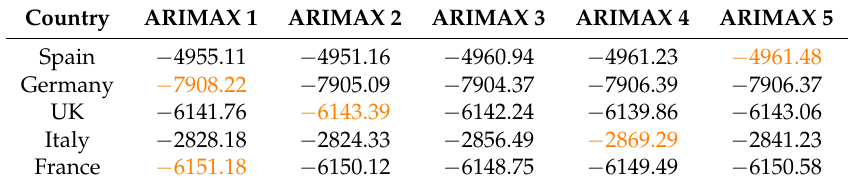
Table 9. AIC for all models and countries for modelling first difference of mean spread.